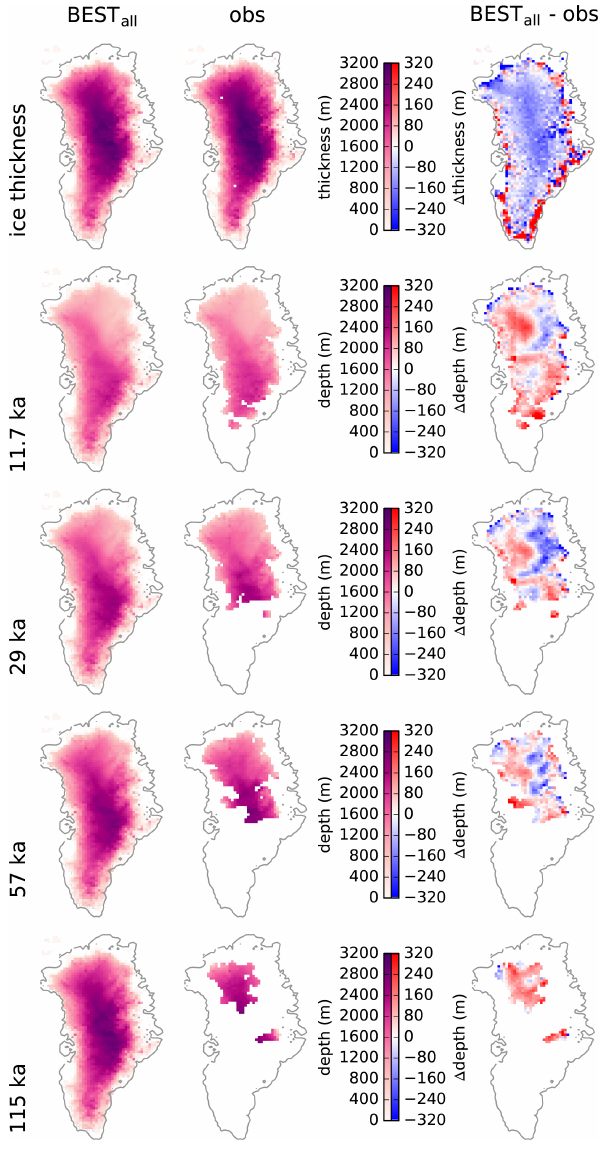
Figure 6. Like Fig. 5, but for simulation BEST all .